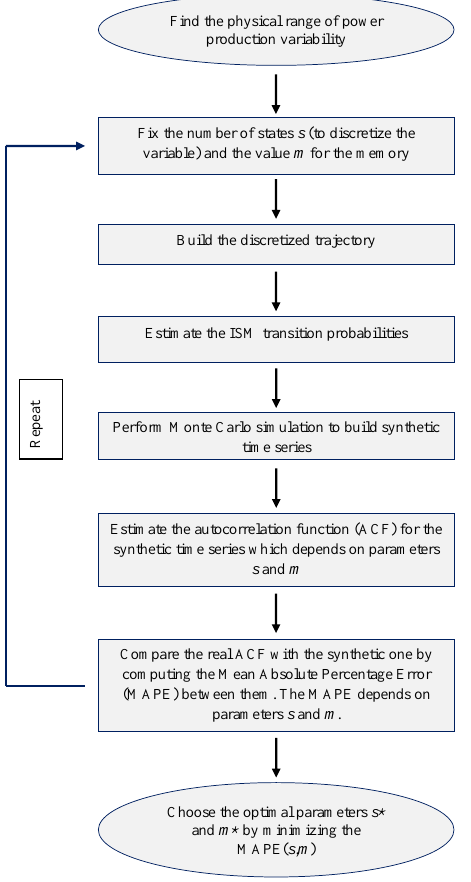
Figure 4. Flow chart—index semi-Markov chain (ISMC) parameter